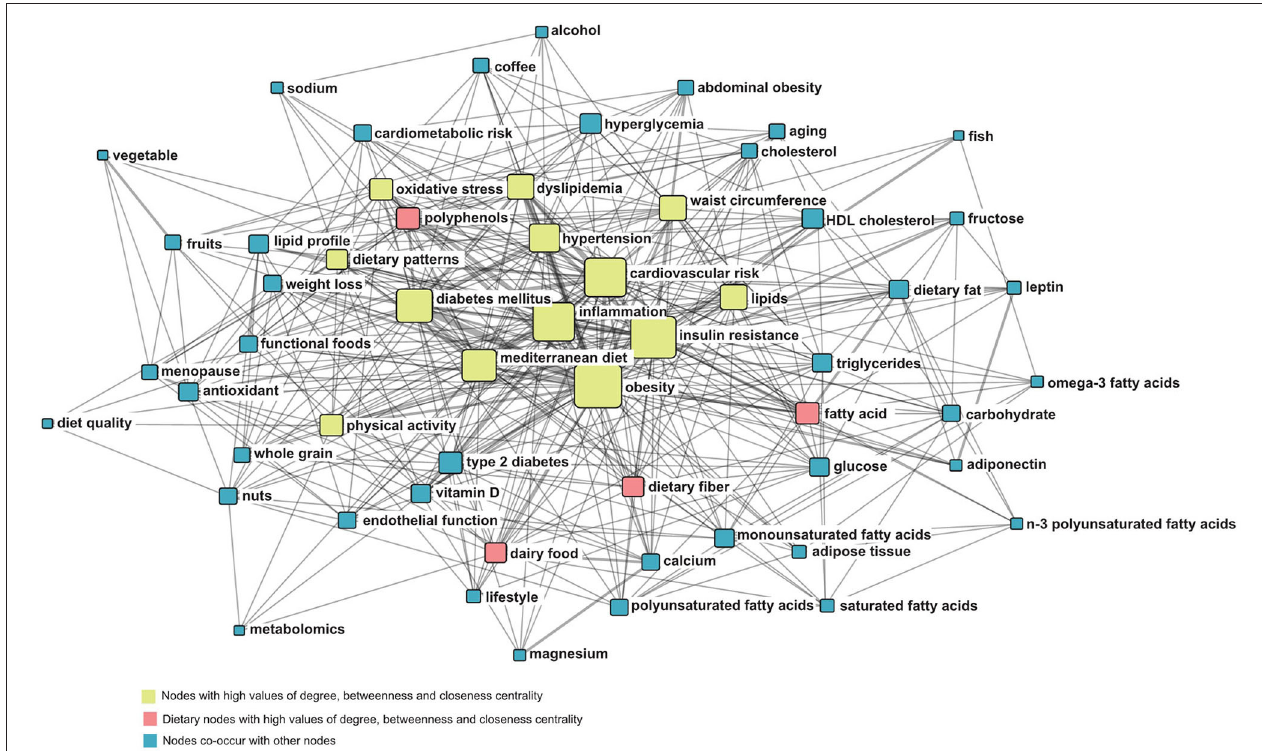
FIGURE 4 | Co-occurrence network of highly frequent keywords.